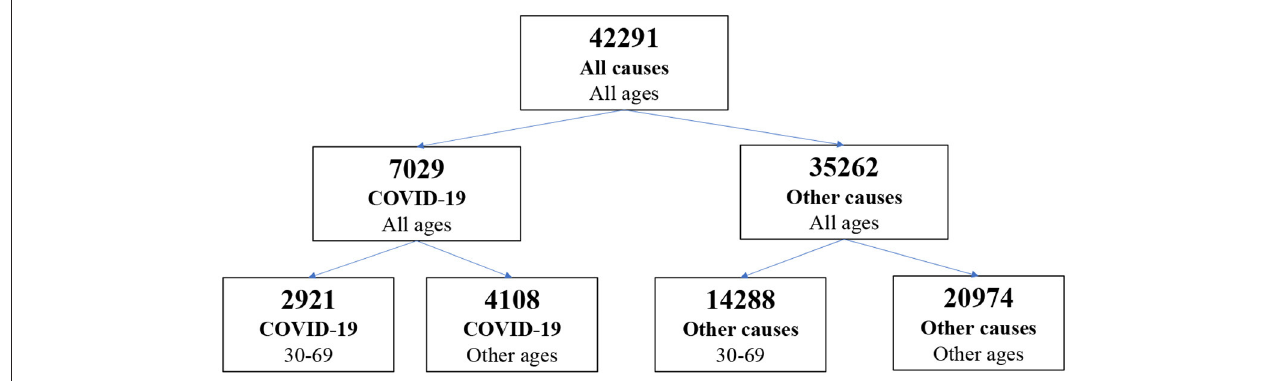
FIGURE 1 | Number of death certificates according to age and cause of death, in three Brazilian capitals,